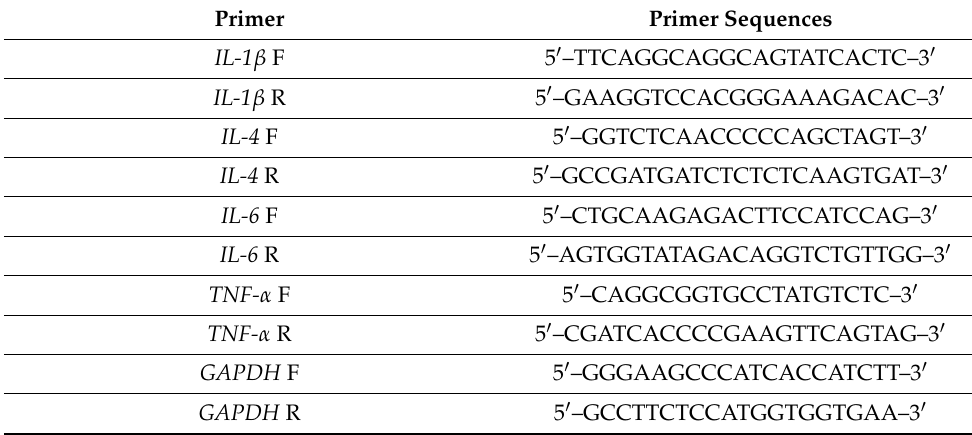
Table 1. Primers for real-time PCR analyses.